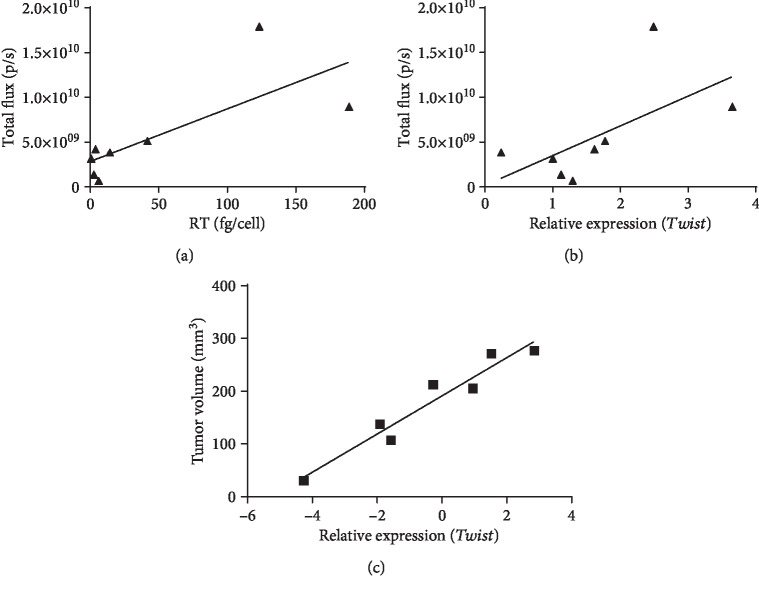
Correlations (Spearman correlation test) between the tumor sizes represented by the total photon flux from tumor on day 18 and the levels of expression of RT_A variant per cell (R = 0.76, p < 0.05) (a); the levels of expression of Twist (normalized against the expression of HPRT1 and represented as fold increase compared to that of the parental 4T1luc2 cells) (R = 0.74, p < 0.05) (b); and palpable tumor volume on day 18 and change in the levels of expression of Twist from day 3 to day 14 in % (R = 0.96, p = 0.0001) (c).